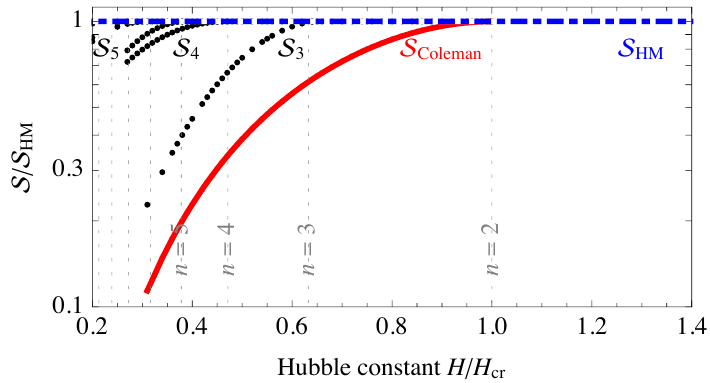
Figure 2 . For the renormalizable quartic potential considered in (cid:12)gure 1, we show the actions of the multi-bounce solutions in units of the Hawking-Moss